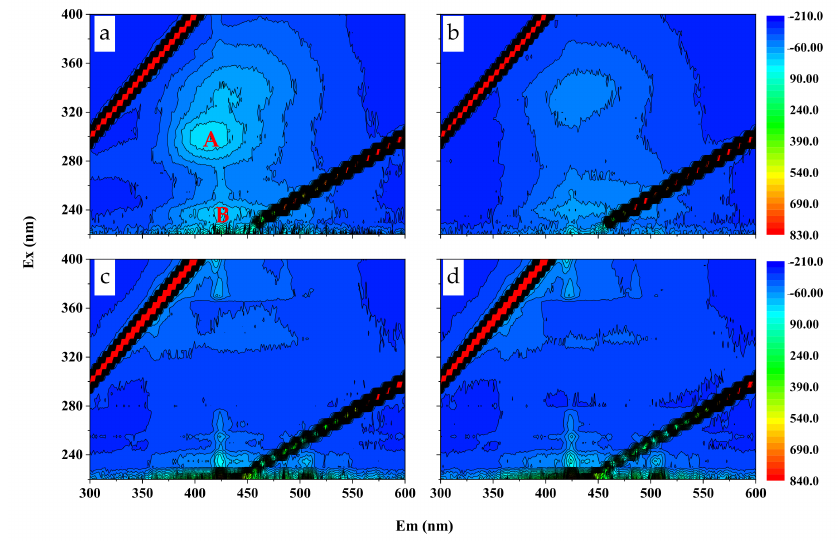
Figure 4. Three-dimensional fluorescence excitation–emission matrix spectra (EEMS) contour maps of soil DOC. ( a ) SL, 0–5 cm; ( b ) SL, 5–10 cm; ( c ) CK, 0–5 cm; and ( d ) CK, 5–10 cm. SL, sewage sludge (SS) application treatment; CK, control treatment without SS